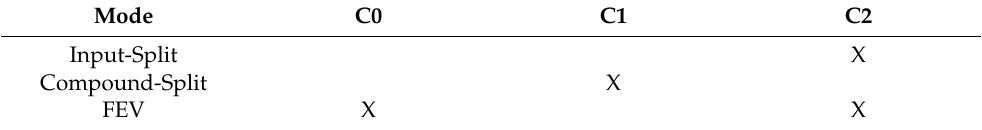
Figure 1. Functional layout of Voltec. The PGs ring gear, sun gear, and carrier are indicated by R, S, and C, respectively. Red arrows indicate the positive direction of power flows. Clutches are indicated by blue labels. Table 1. Clutches operations for Voltec operating modes provided by General